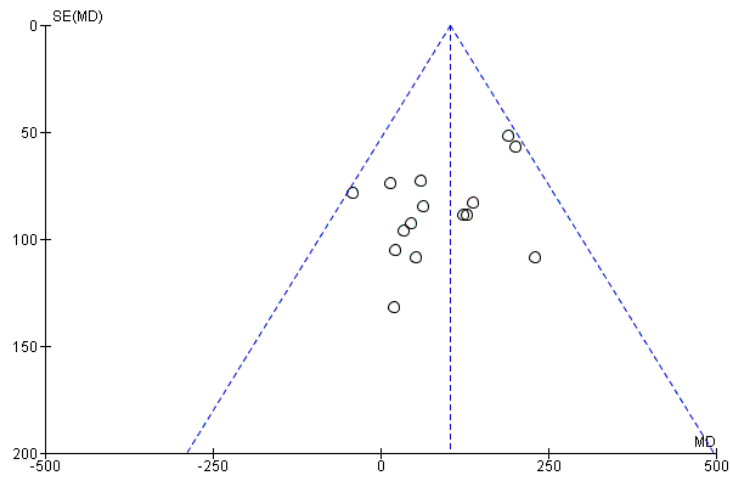
Figure 8. Funnel plot with estimated 95% confidence intervals for meta-analysis of the effect of vitamin D intervention on birthweight.